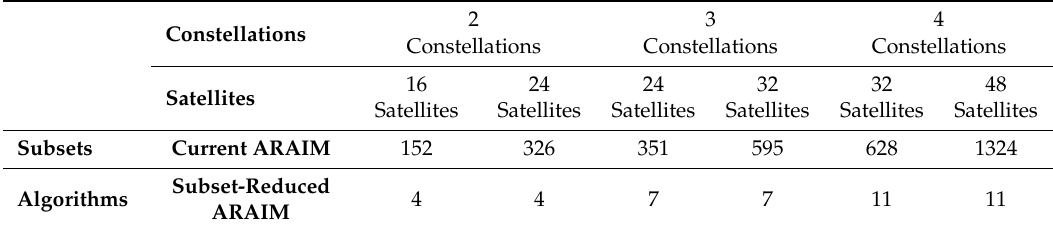
Table 2. Number of